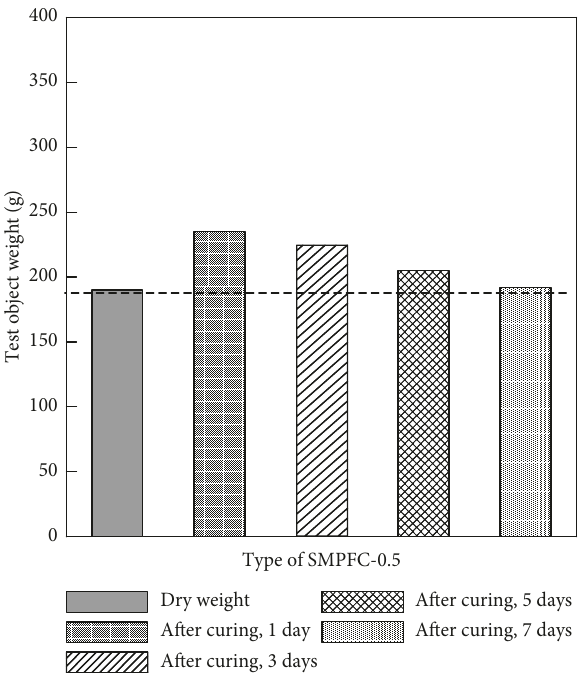
Figure 14: Test results of moisture content (SAP 1%).